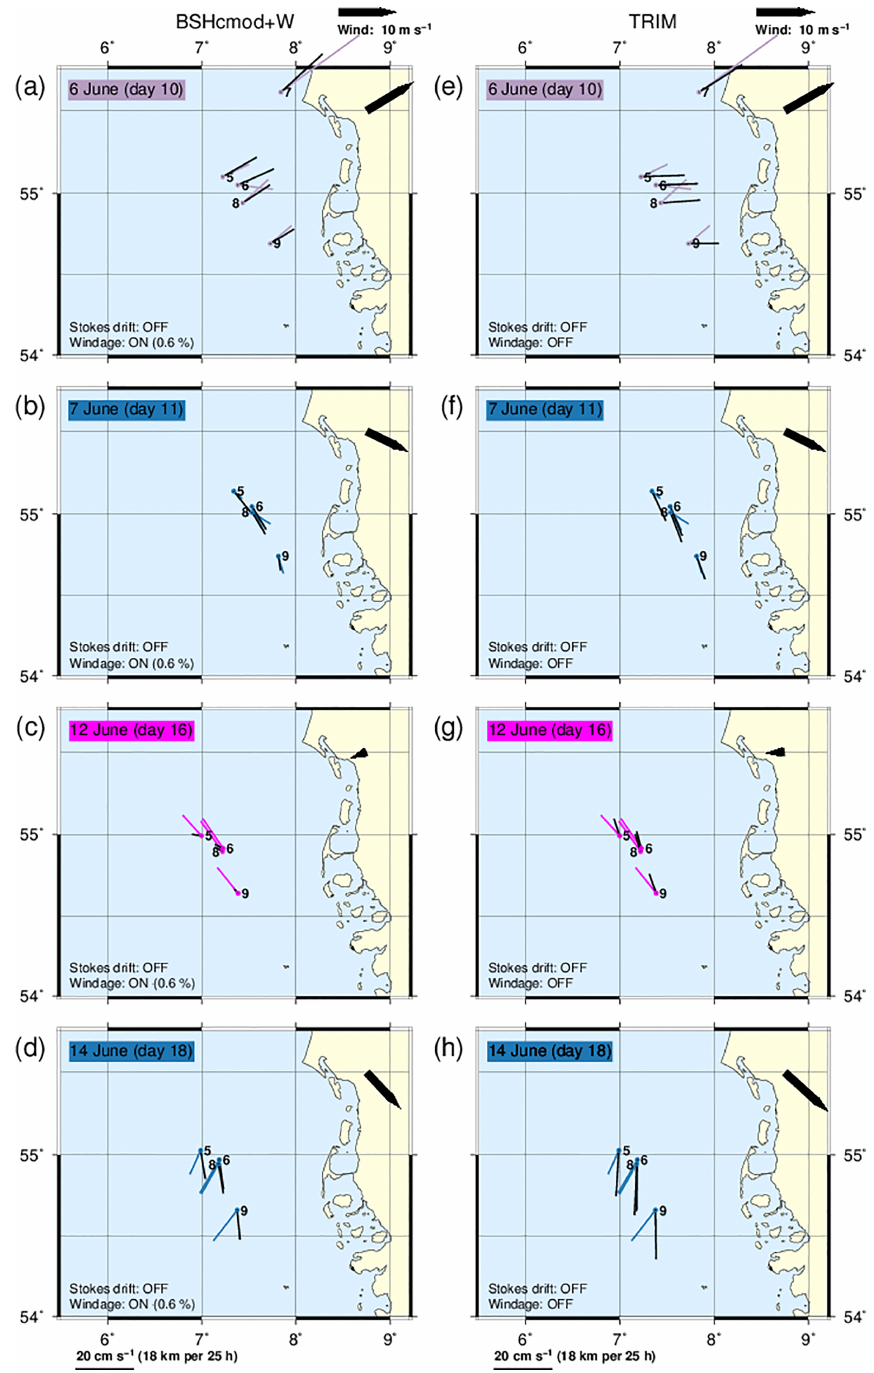
Figure 8. Continued from Fig. 7.